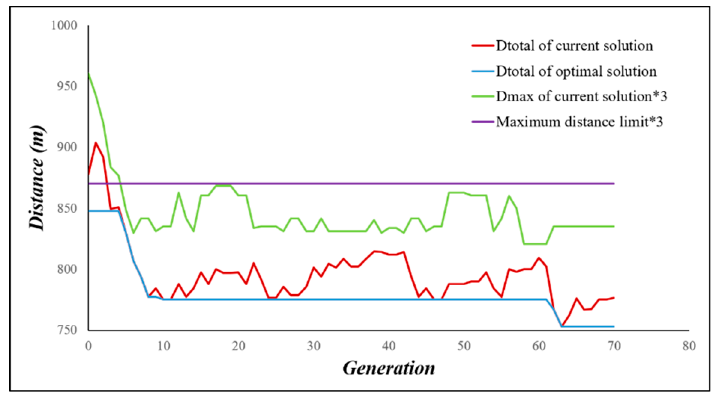
Figure 16. Solution convergence diagram.